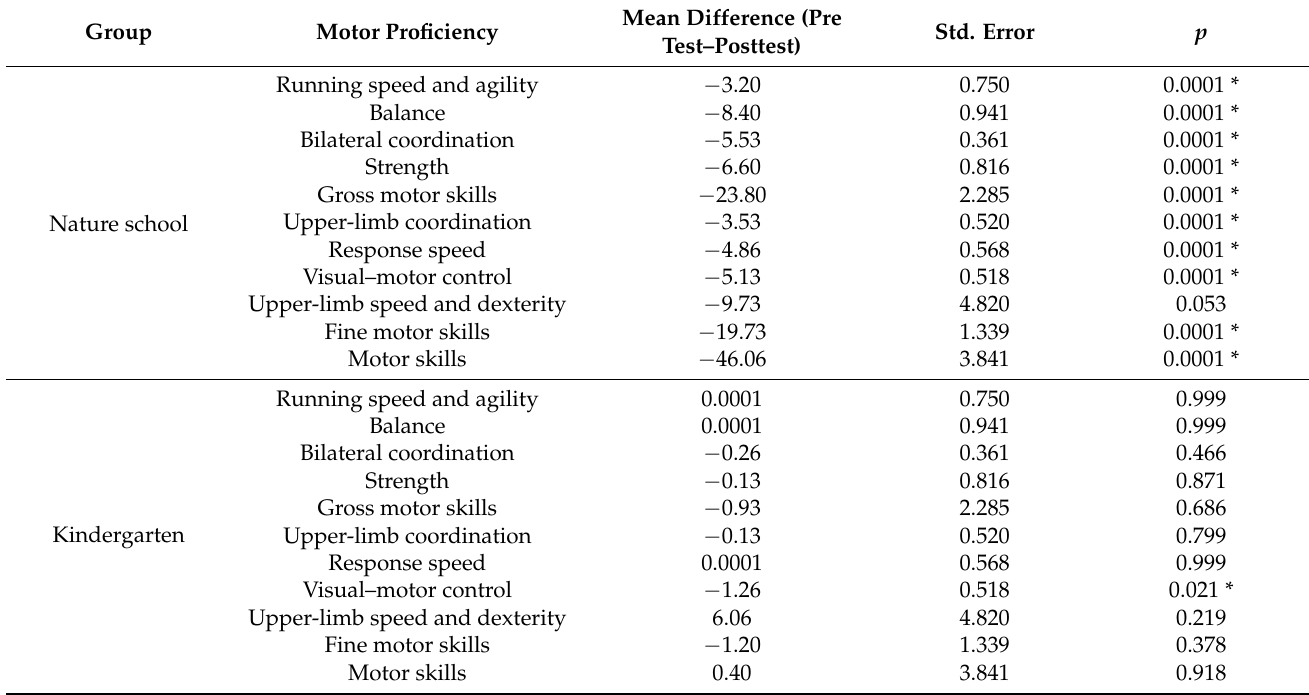
Table 2. Differences of the motor proficiencies within groups pre- to posttest.